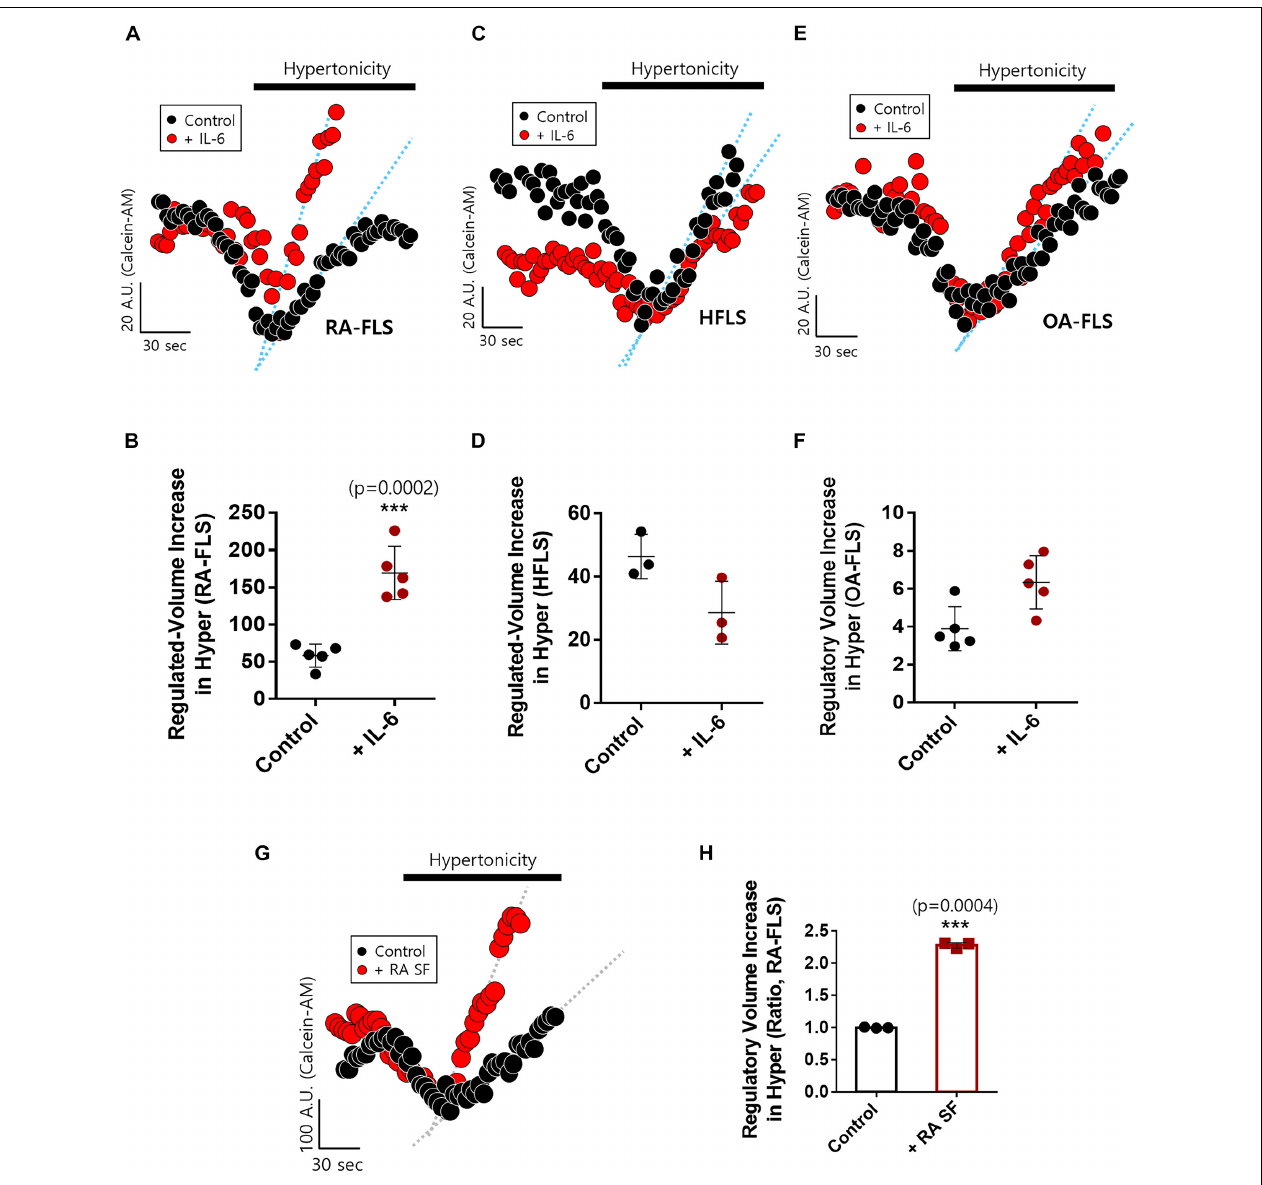
FIGURE 2 | Interleukin (IL)-6-stimulated rheumatoid arthritis fibroblast-like synoviocytes (RA-FLS) were sensitive to hypertonic stimulation. Volume changes in FLS on stimulation with a hypertonic solution (400 mOsm/L) pre-treated with or without 50 ng/ml IL-6 for 48 h in (A) RA-FLS, (C) human FLS (HFLS), and (E) osteoarthritis FLS (OA-FLS). The bars represent the mean ± SEM of volume changes with or without IL-6 treatment in (B) RA-FLS, (D) HFLS, and (F) OA-FLS. [*** p < 0.001, *: Control vs + (IL)-6]. (G) Volume changes in RA-FLS on stimulation with a hypertonic solution (400 mOsm/L) pre-treated with or without synovial fluid of RA patients for 6 h in a migration assay. (H) The bars represent the mean ± SEM of volume changes with or without synovial fluid of RA patients in RA-FLS. Hypertonic solution (hyper) ( n = 3, *** p < 0.001, *: Control vs + RA